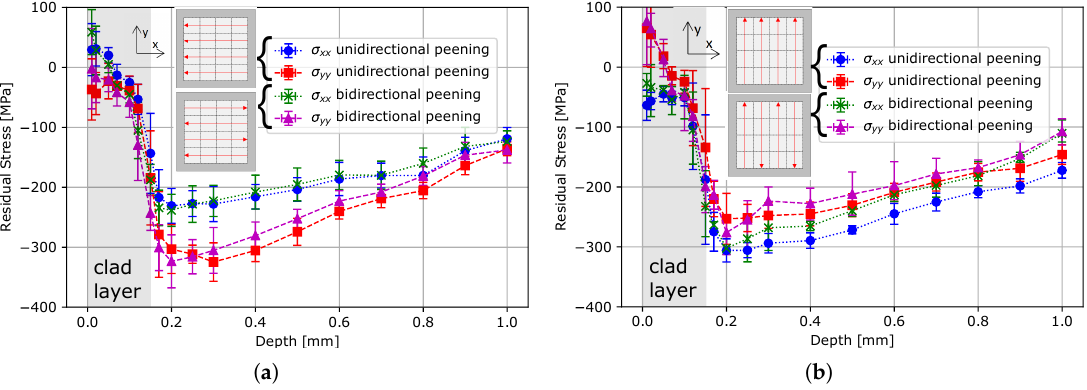
Figure 5. LP with unidirectional and bidirectional advancing directions for AA2024-T3clad: ( a ) advancing direction parallel to the rolling direction; ( b ) advancing direction orthogonal to the rolling direction. The gray area indicates the clad